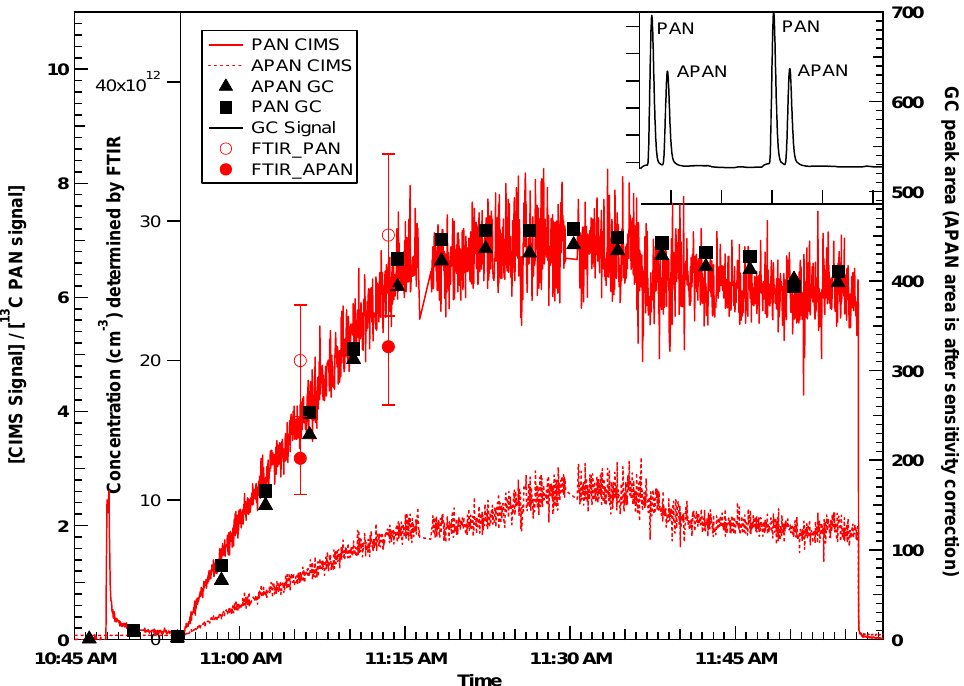
Fig. 4. An example of the real-time raw signal of a sample from the environmental chamber as seen by the TD-CIMS, NCAR Fast-GC, and the FTIR. The insert shows the chromatogram of PAN and APAN. Note that the GC sensitivity to APAN is about 0.6 times that of PAN (determined by Flocke et. al., 2005). After the GC sensitivity correction, the data agree very well (black square and triangles). The open and filled circles are the discrete FTIR measurements for PAN and APAN, respectively, with estimated measurement